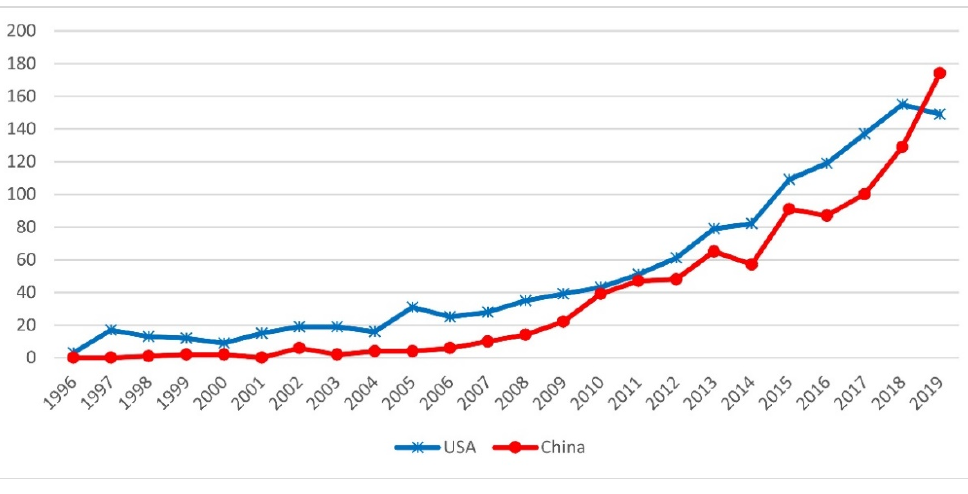
Figure 6. Temporal evolution (1996–2019) of FRAs references (number of records) in WoS databases classified by ‘Countries /Regions’, comparing production by the US and China.